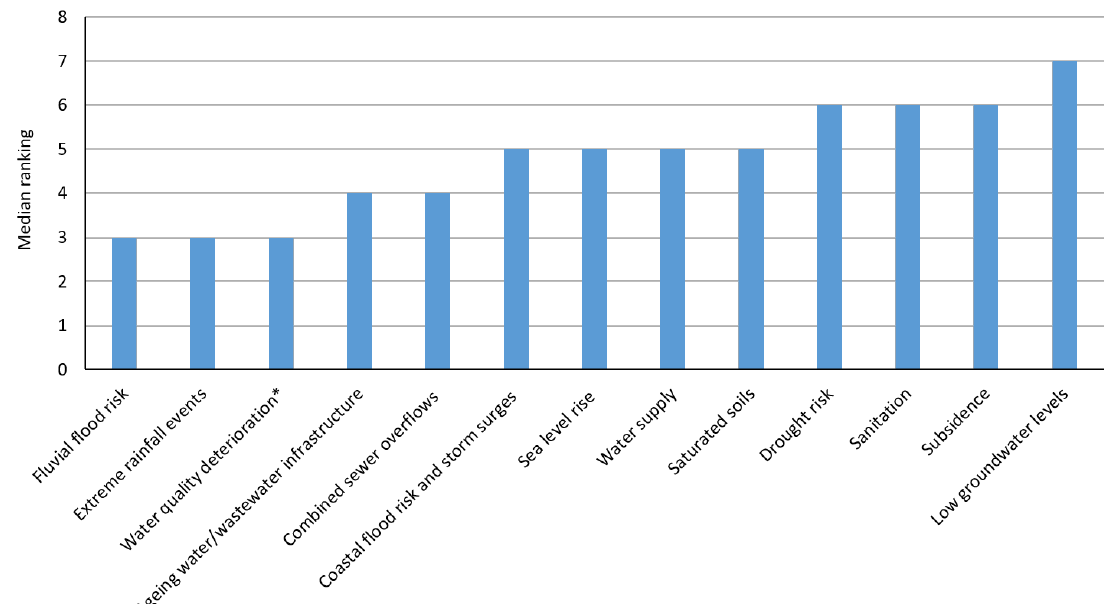
Figure 3. Median ranking of the water challenges by the whole sample population ( n = 64). Respondents were asked to rank the importance of each challenge in their city using a 1 (very important) to 10 (not important) scale; lower rankings denote greater importance of the challenge. The bars are in the order of median score. *Water quality deterioration also includes concern over river health.